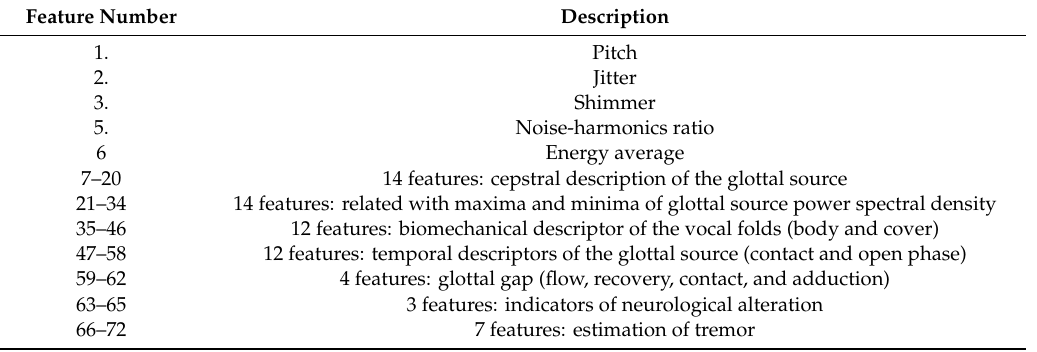
Table 1. Set of 72 features estimated by the tool regarding its characteristics and